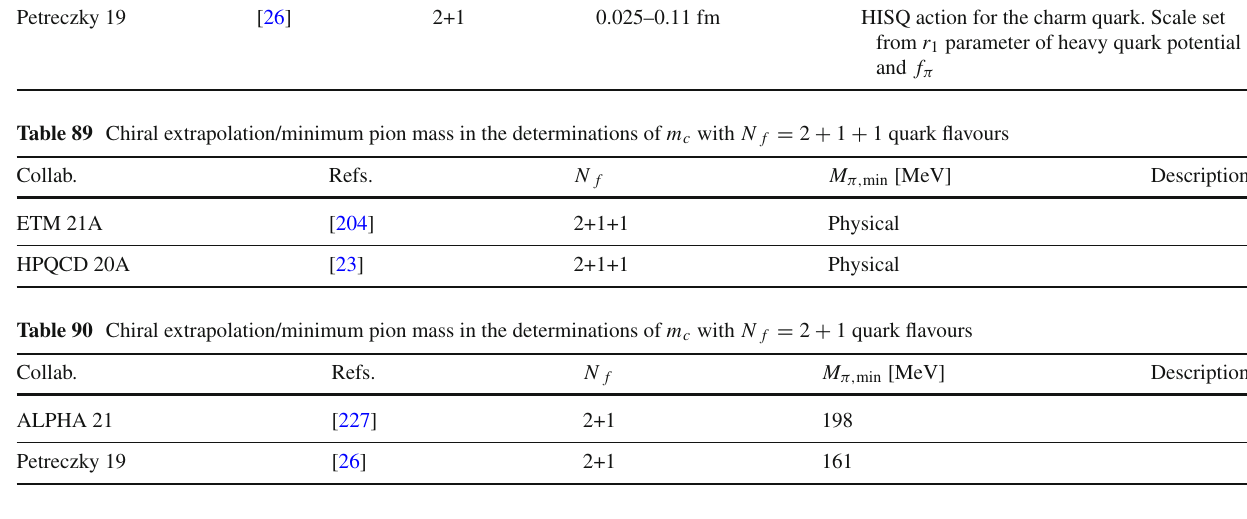
Table 91 Finite-volume effects in the determinations of m c with N f = 2 + 1 + 1 quark flavours Collab.